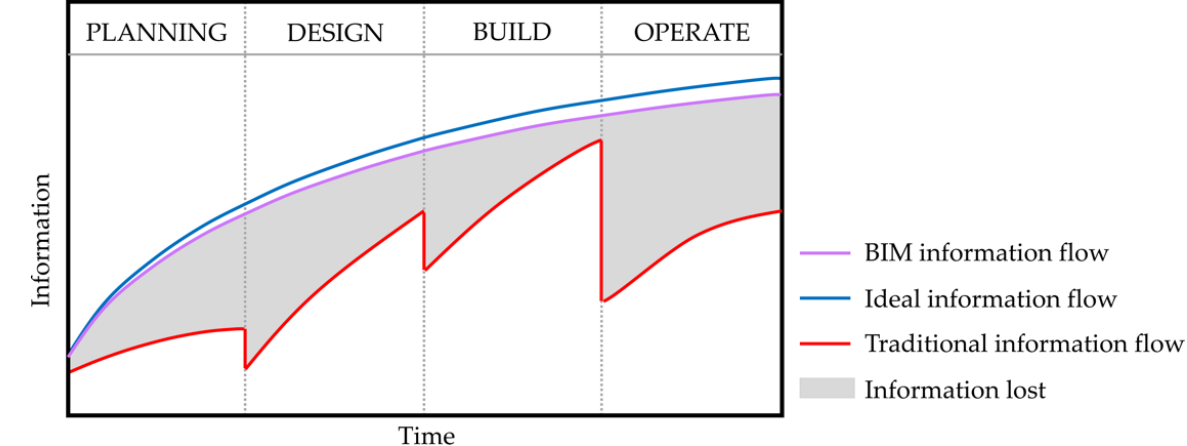
Figure 6. Information loss in the building life cycle and the BIM curve (re-elaboration based on Eastman et al. [12] and Gallaher et al. [11], as in Figure 1).